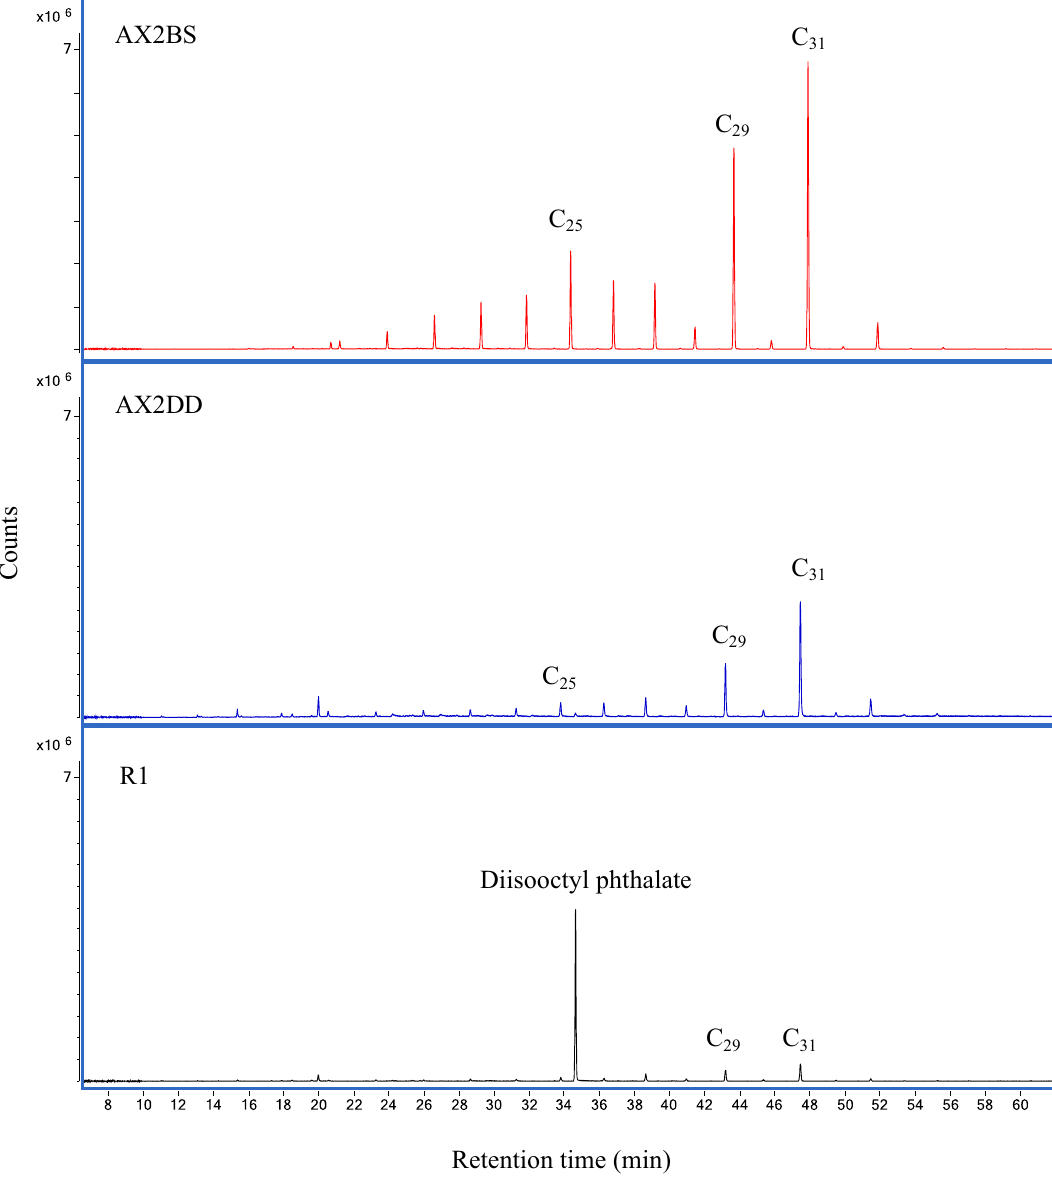
Figure 1. Extracted Ion Chromatograms from samples AX2 BS, AX2 DD and R1. In the n-alkane fraction (F1) of R1 only one phthalate was characterized along with some n-alkanes. The AX2 LS and DD sample chromatograms share similarities among their n-alkanes